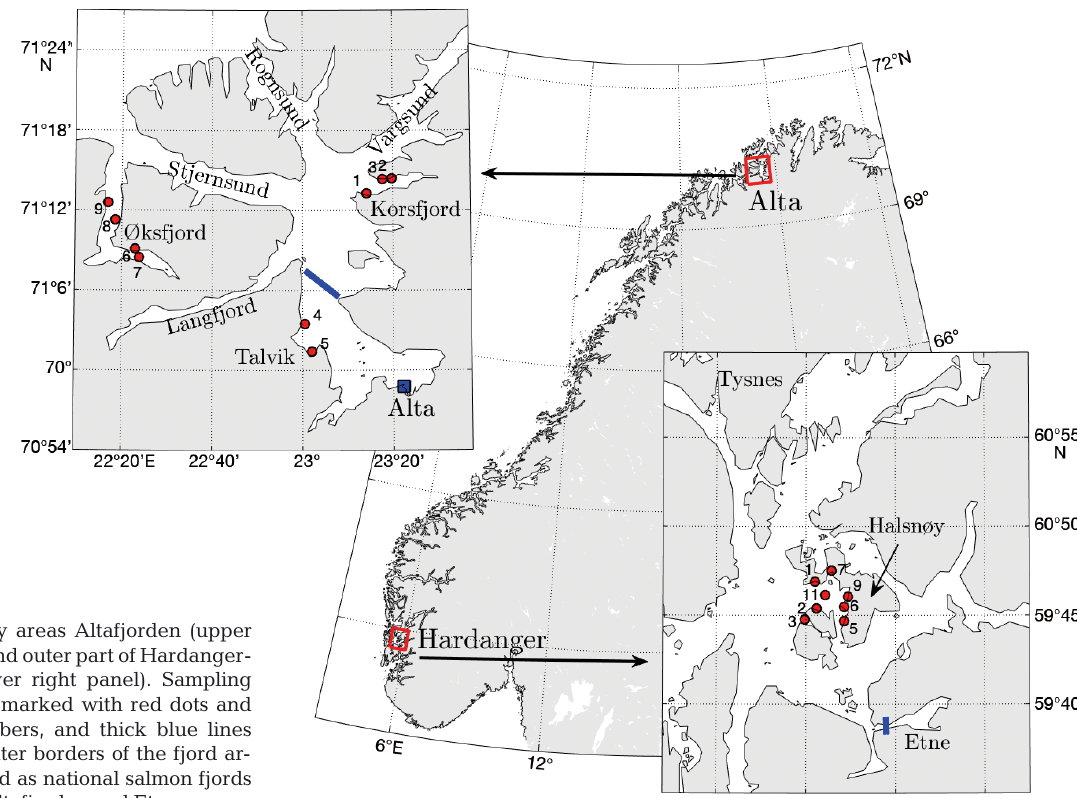
Fig. 1. Study areas Altafjorden (upper left panel) and outer part of Hardanger - fjorden (lower right panel). Sampling stations are marked with red dots and station numbers, and thick blue lines show the outer borders of the fjord ar- eas protected as national salmon fjords in Altafjorden and